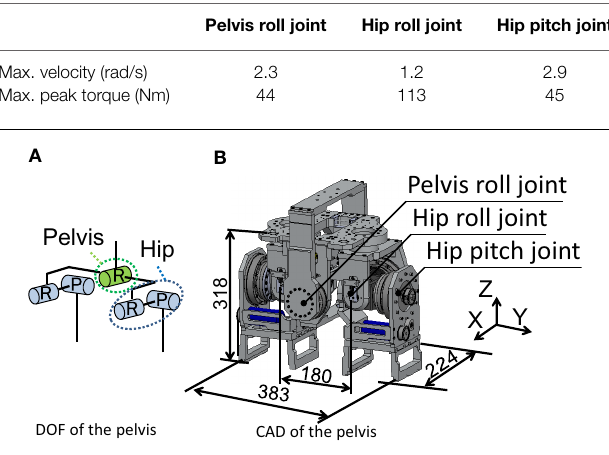
where l leg is the leg length. The control block diagram is shown in TABLE 1 | Requirements .